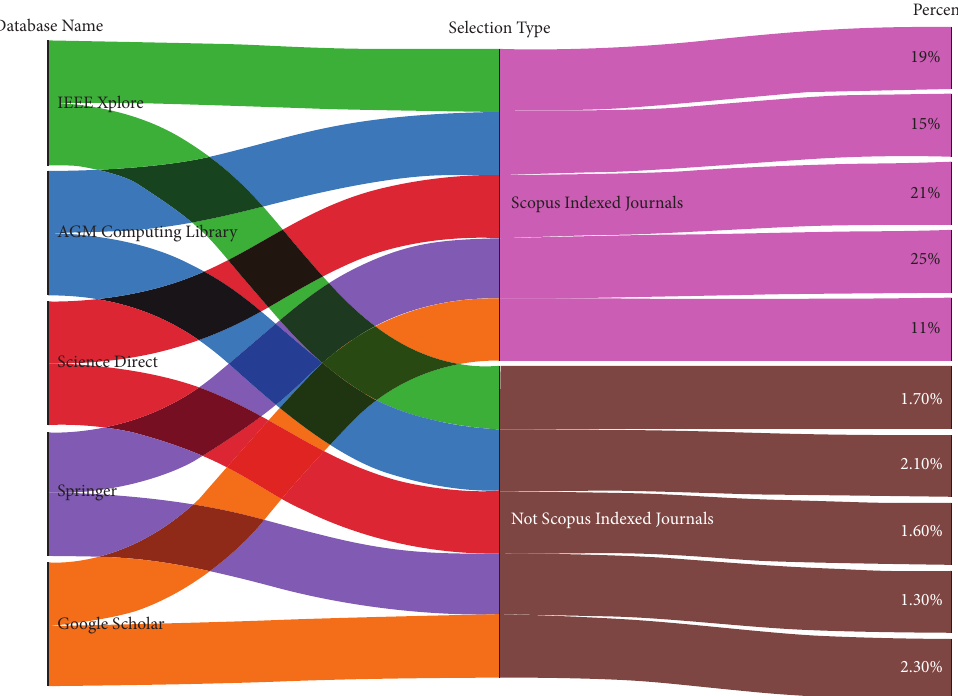
Figure 5: Distribution of Scopus indexed articles among the databases.